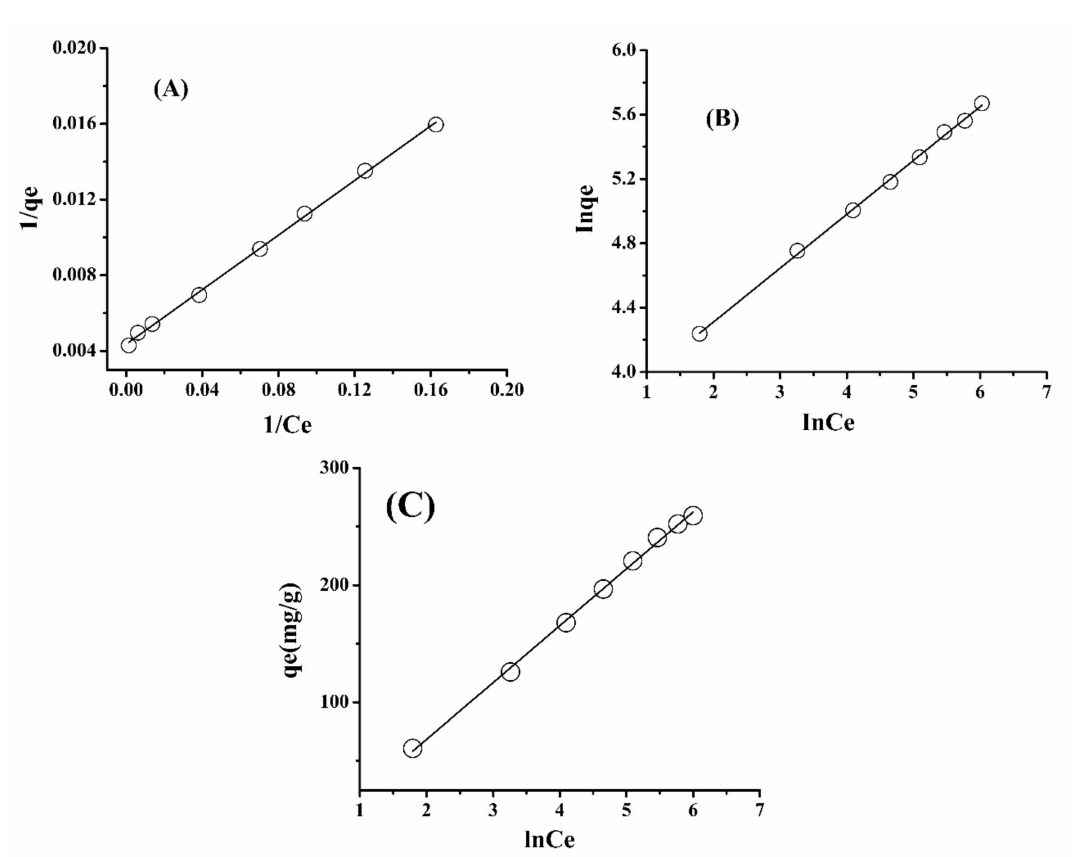
Figure 4. Adsorption isotherm models for Pb(II) adsorption onto chemically modified SM, Langmuir model ( A ) and Freundlich model ( B ) and Temkin ( C